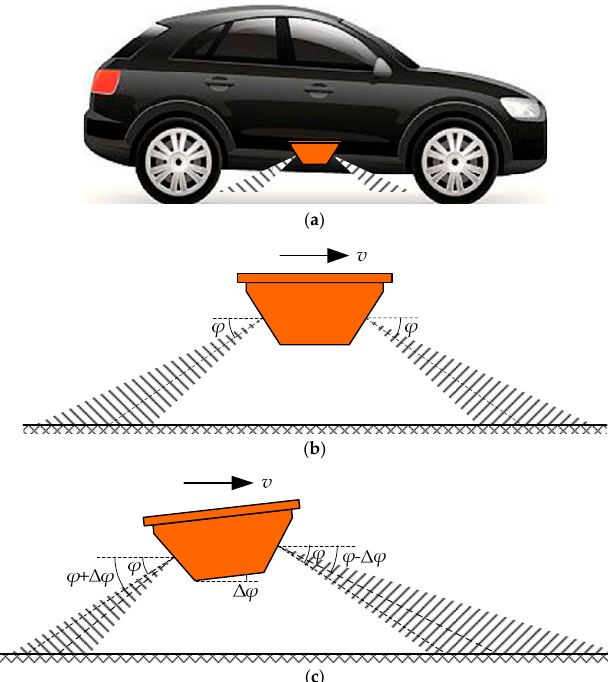
Figure 4. Vehicle-borne dual-channel DRS with the Janus configuration: ( a ) Installation schematic; ( b ) Schematic diagram of working principle in the ideal situation without a deflection angle; ( c ) Schematic diagram of working principle in the actual situation with a deflection angle.